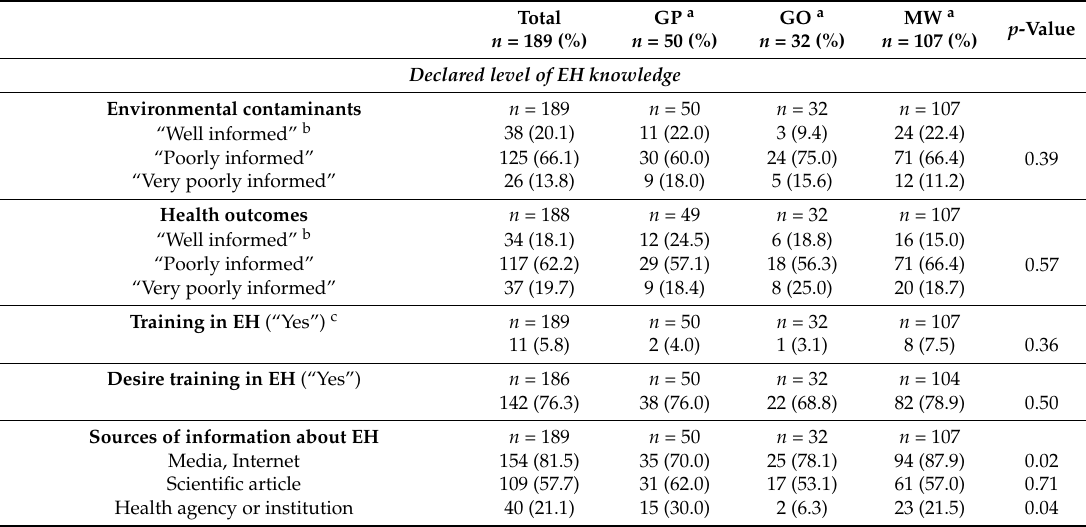
Table 3. Sources of information and difficulties encountered by perinatal health professionals (HPs) in advising pregnant women about environmental health (EH).